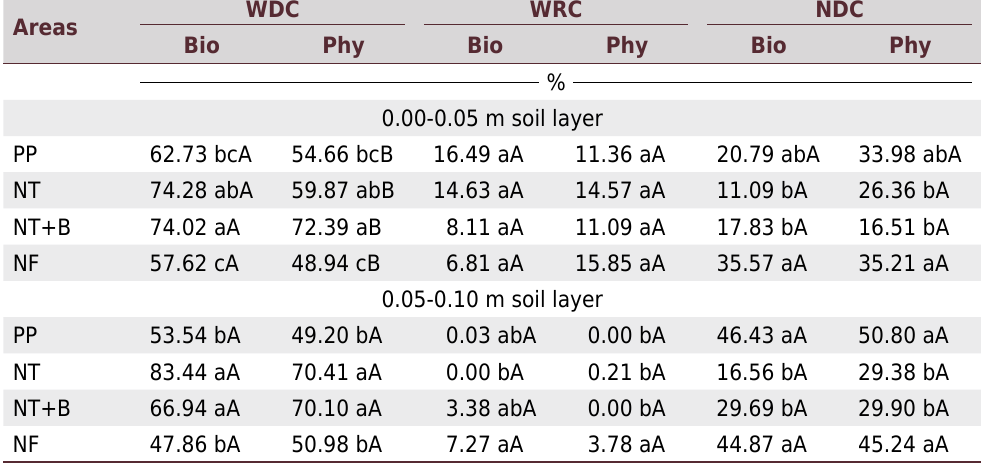
Means followed by the same lower-case letter in the column do not differ between management systems for the same type of aggregate. Means followed by the same capital letter in the row do not differ among the